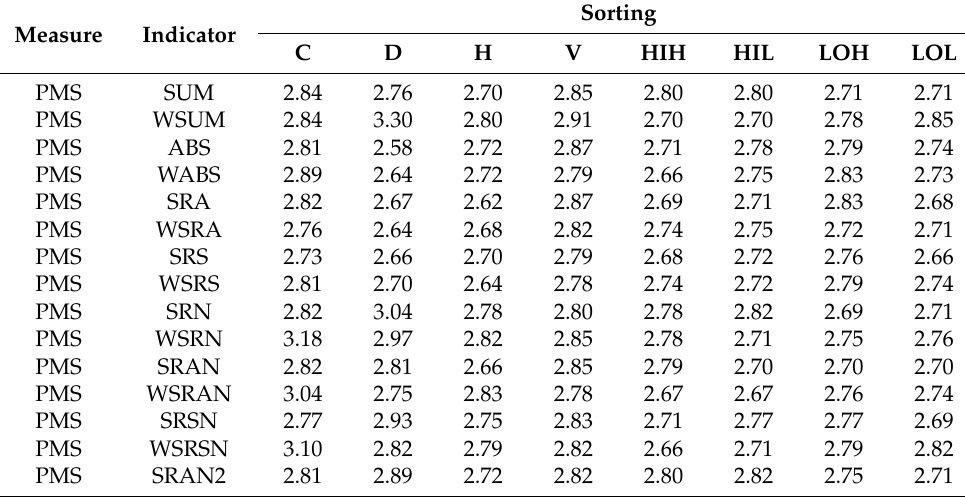
Table 10. Computational results for the NEH algorithm: ARPD values